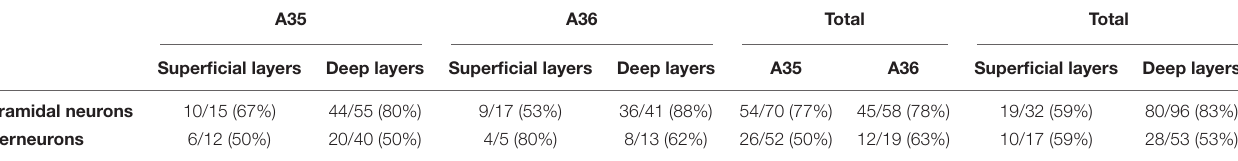
TABLE 3 | Distribution of the resonant pyramidal neurons and GABAergic interneurons in the superficial and deep layers of the areas 35 (A35) and 36 (A36) of the PRC.